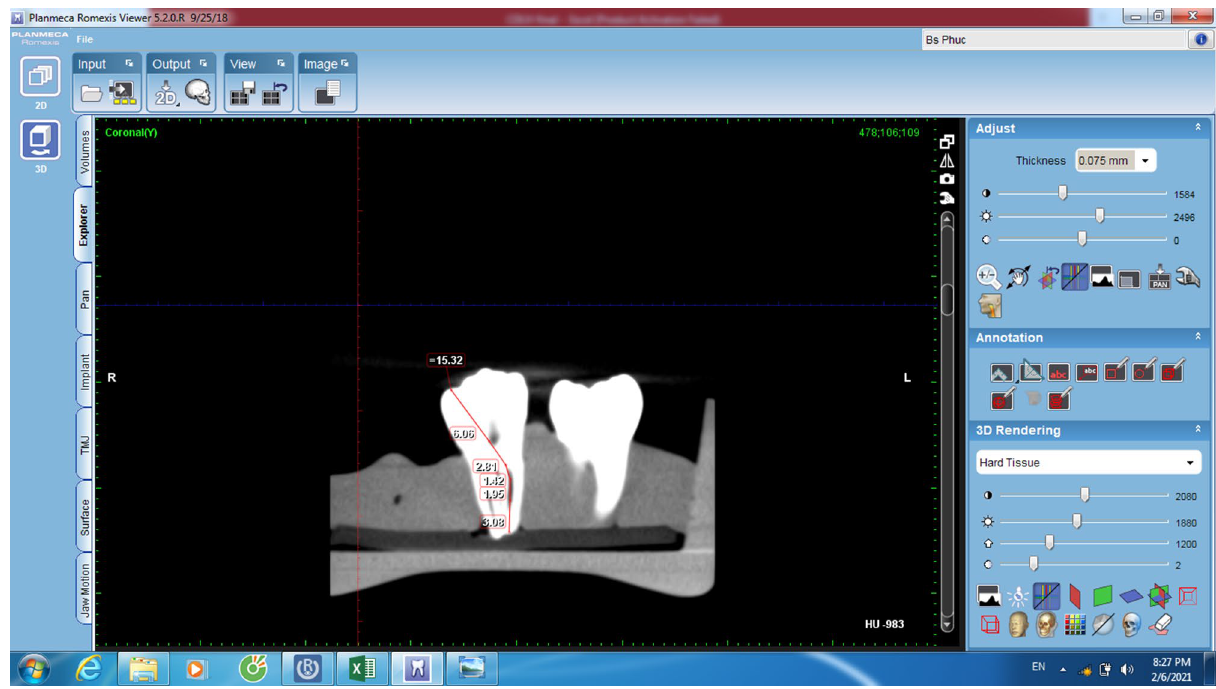
Figure 2. Romexis Viewer measurement on the conventional CBCT